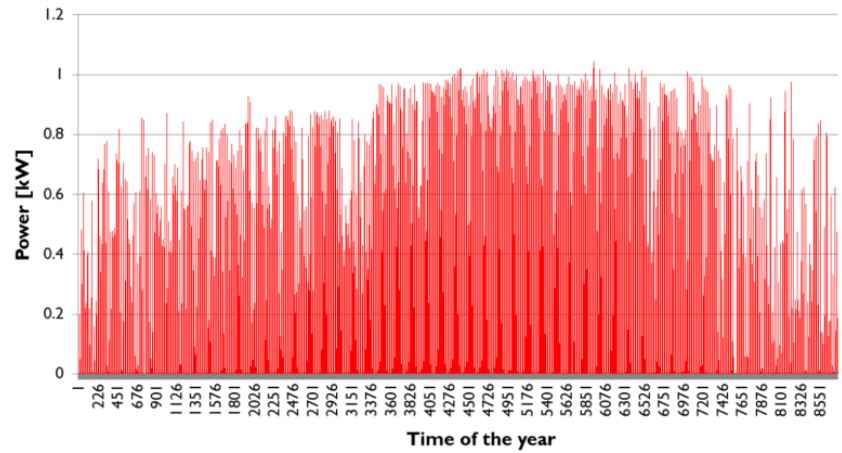
Figure 7. PV system power production as normalized in 1 kW.